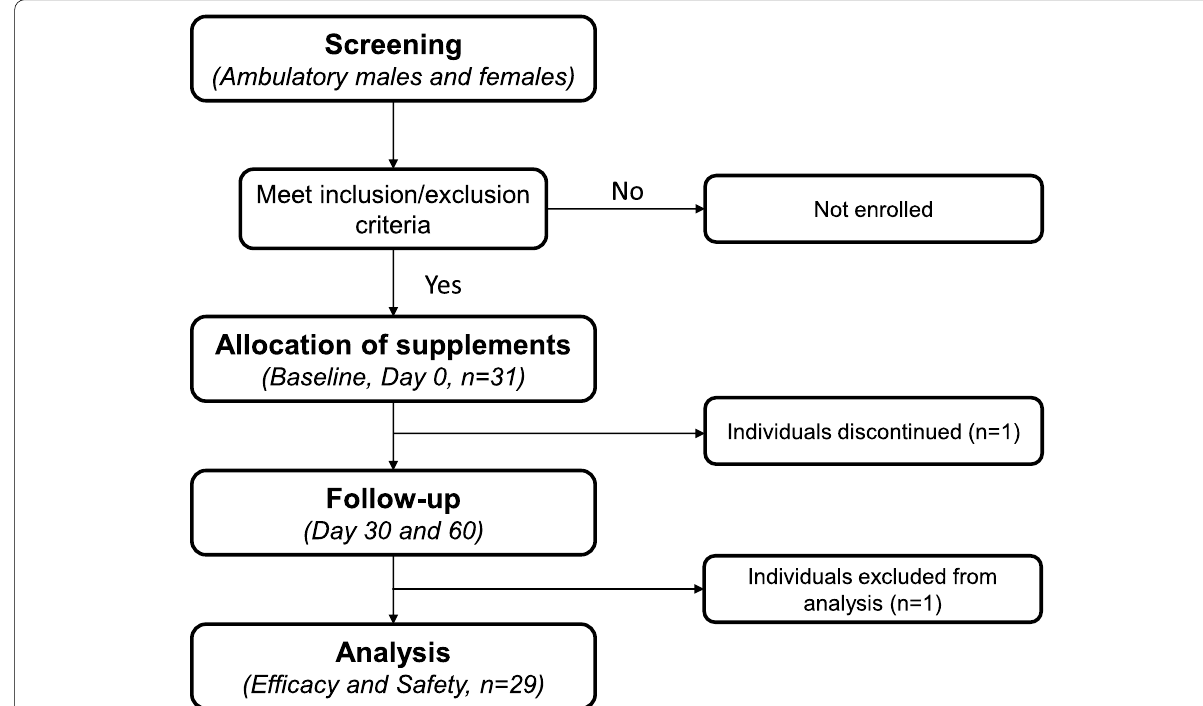
Fig. 1 Flow diagram for the study design of supplementation with Pro‑Resolving Mediators and Curcumin Elite ™ Turmeric Extract in healthy men and women. 29 individuals were included for the safety and efficacy